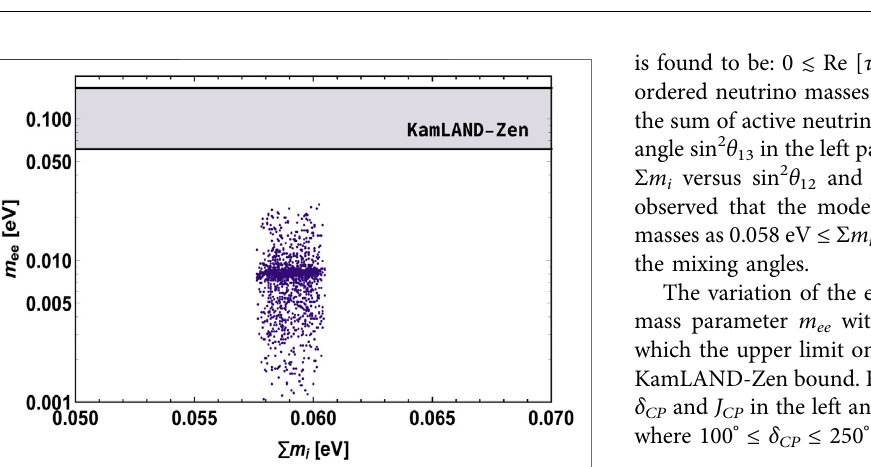
Frontiers in Physics |